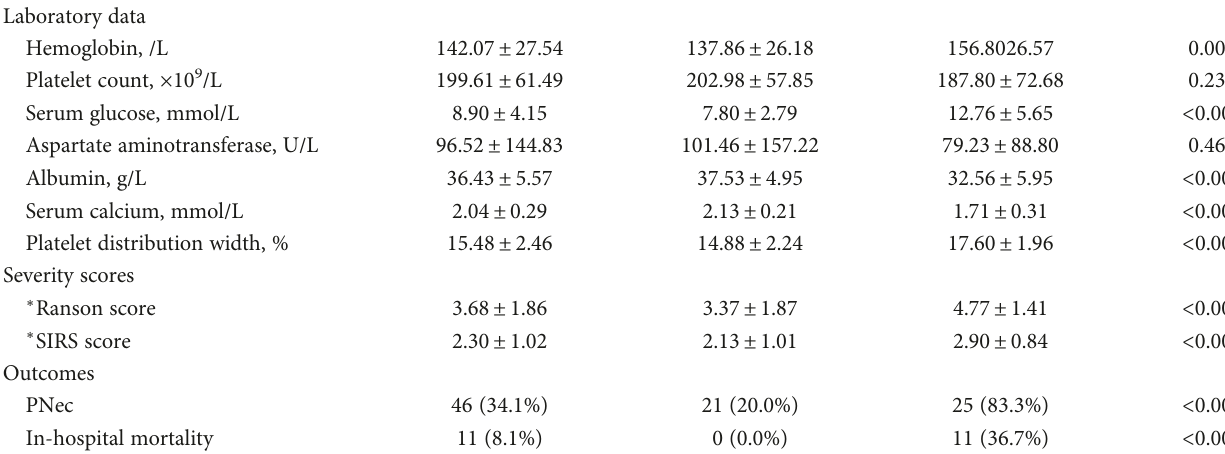
Table 4: Laboratory and clinical data of the patients with and without